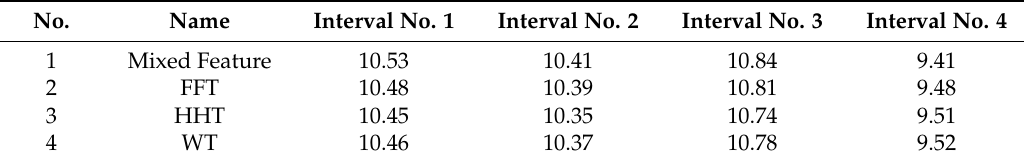
Table 7. Tracing effect of vibration sources between different methods (cm).